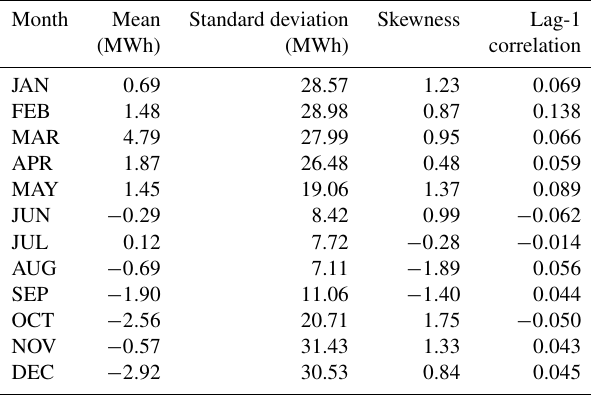
Table 3. Monthly statistical characteristics of residuals derived from the application of Indirect Model B.